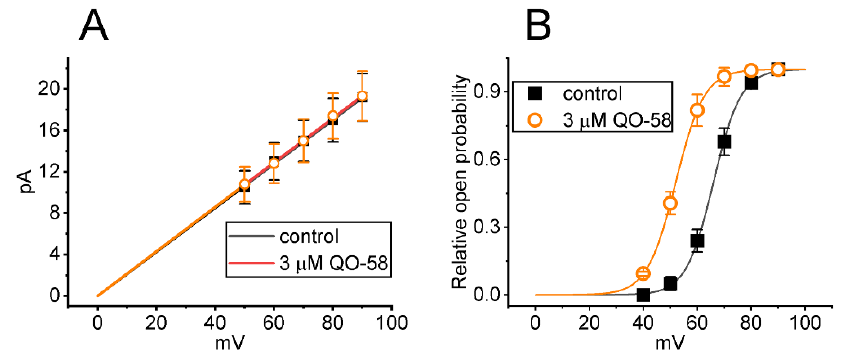
Figure 7. Effect of QO-58 on single-channel conductance ( A ) and activation curve ( B ) of BK Ca channels in GH 3 cells. In this series of inside-out current recordings, we voltage-clamped the excised patched at different levels of membrane potentials, and the recording pipette was filled with K + -enriched solution. ( A ) Average I-V relationship of single BK Ca -channel currents (i.e., linear regression between membrane potential and mean single-channel amplitude) obtained in the absence (black filled squares) and presence (orange open circles) of 3 µ M QO-58 (mean ± SEM; n = 8 for each point). Of note, the linear relationship of BK Ca channels between the absence and presence of QO-58 is superimposed, and the value of reversal potential with or without the QO-58 addition was pointed toward zero mV. ( B ) Steady-state activation curve of BK Ca channels obtained in the control period (black filled squares) and during exposure to 3 µ M QO-58 (orange open circles) (mean ± SEM; n = 8 for each point). Sigmoid lines indicate the best fit to a Boltzmann function as stated in Section 4. Of note, there is a leftward shift of the activation curve of the channel, although neither single-channel conductance of the channel nor gating charge of the curve was altered by QO-58 presence.